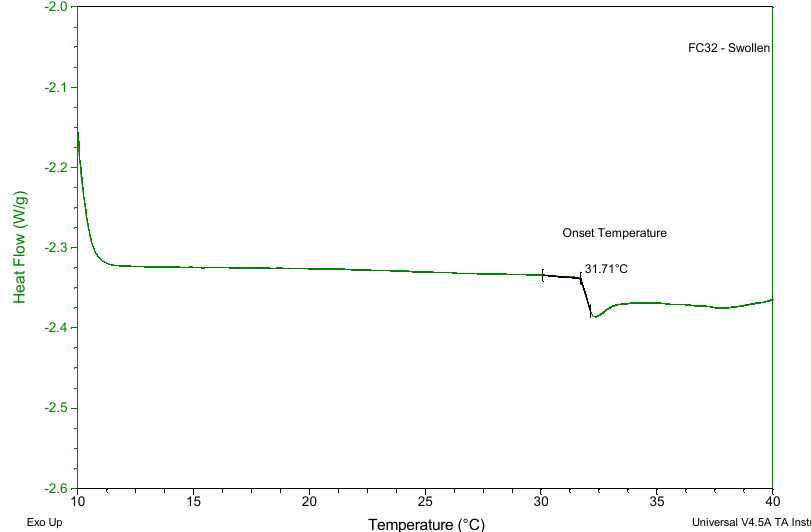
7 of 19 Figure 4. UV spectroscopy of the aqueous solutions of FP14, FP32, FP33, FP34, FP35, FP36, and FP37. 2.4. Di ff erential Scanning Calorimetry DSC is a technique that is used for thermal characterisation of polymeric materials. During the heating or cooling stage, the heat fl ow linked with material transitions as a function of temperature and time is plo tt ed [48]. DSC analysis was conducted to deter- mine the following: the glass transition temperature (Tg) and the LCST of the chemically crosslinked gels. Chemically crosslinked hydrogels were not tested for LCST using cloud-point meas- urements and UV spectroscopy due to the existence of covalent bonding that restricted their dissolution in water. For the determination of LCST, fully swollen chemically cross- linked hydrogels were used. A fully swollen state would improve the chance of noticing